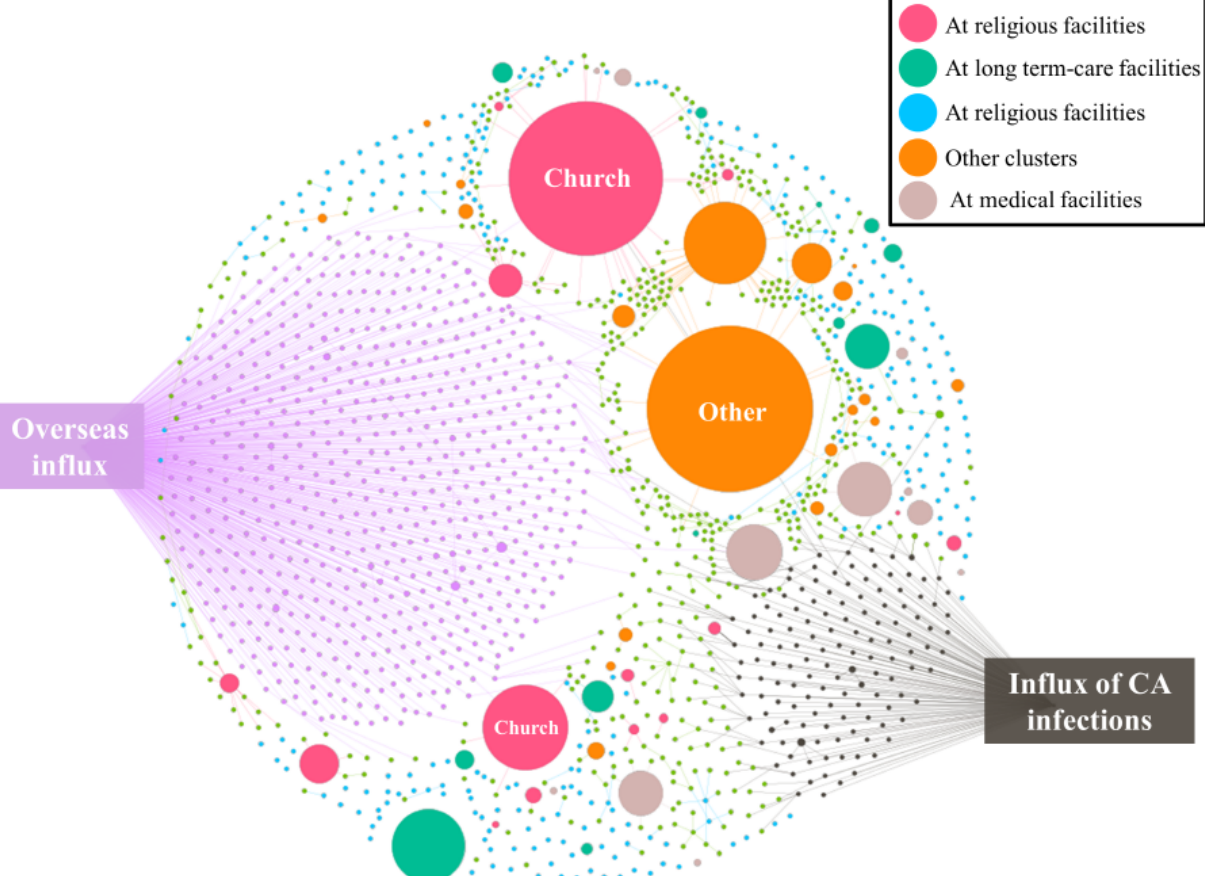
Figure 3. Infection spread network visualization of COVID-19 in South Korea from January 19, 2020, to April 7, 2020. Each dot represents an individual, and each line represents an individual’s tracing results. Overseas influx and influx of community-acquired infections (Daegu and two cities in Gyeongbuk [Cheongdo and Gyeongsan]) are shown by 641 and 229 connected dots, respectively. CA: community-acquired.